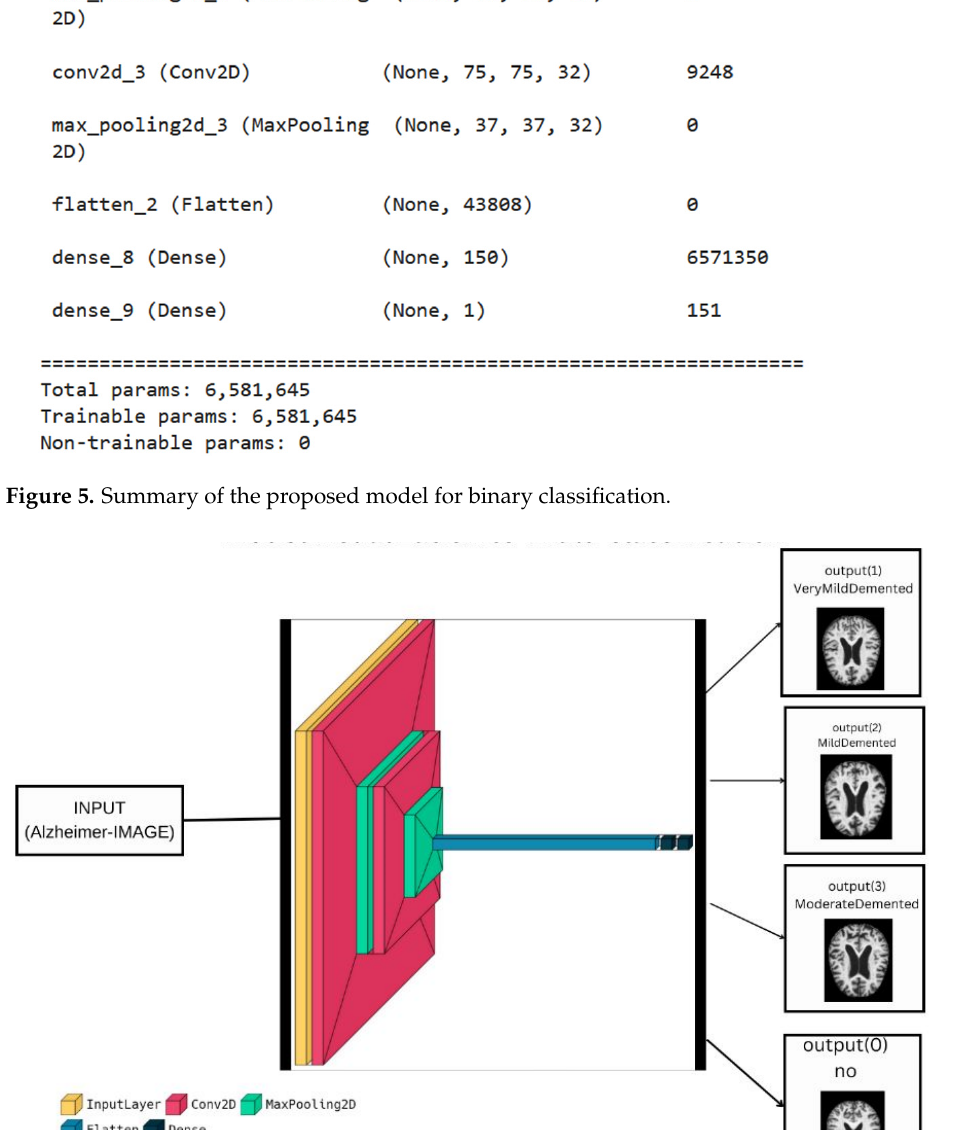
Figure 7. Summary of the proposed model for multi-classification. The pseudocode of our algorithm is shown in Algorithm 1. The proposed deep learn- ing model for binary and multi-classification tasks is based on a lightweight architecture that can be trained efficiently on large datasets. The use of data augmentation techniques helps to improve the generalization performance of the model, making it more robust to variations in the input data. The model achieves high accuracy on the validation dataset, demonstrating its effectiveness in performing binary and multi-classification tasks on im- age datasets. Compared to existing methods, the proposed model is simpler in terms of the num- ber of layers and parameters, which results in faster training times and lower computa- tional resources. Additionally, the use of data augmentation techniques further improves